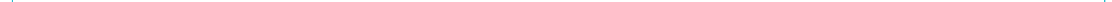
Figure 1: Common circulation between two mice in the heterochronic parabiosis model. (A) At 2 weeks after parabiosis surgery, the old mouse of the parabiotic pair received an injection of ProSense 750FAST through the tail vein (position a) and ProSense 750FAST was activat- ed around the needling wound in the young mouse of the parabiotic pair (position b), which was imaged with the FMT system 24 hours after injection. ProSense 750FAST agent was activated in the young mouse, which indicated that the mice had developed a shared blood circula- tion. (B) Absolute weights of the pairs (parabionts) measured at various times during recovery (8 Y/O pairs and 5 Y/Y pairs). Immediately fol- lowing the surgery, both groups appeared to lose weight, which was followed by steady normalisation of the body weight. FMT = fluorescence molecular tomography; O = old; Y =